Question: Which visualization type does this figure use?
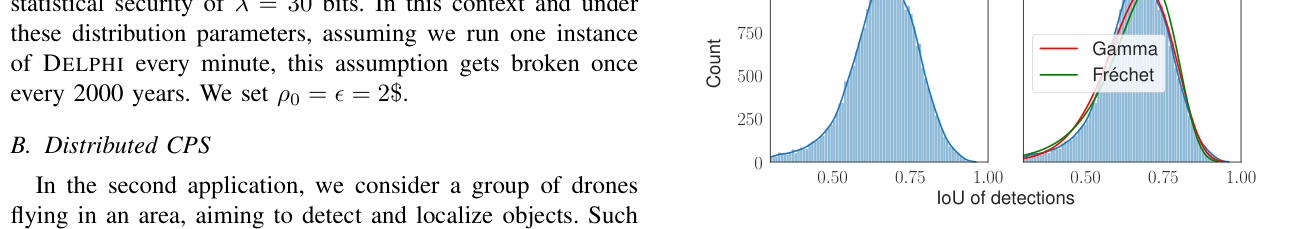
Answer: histogram